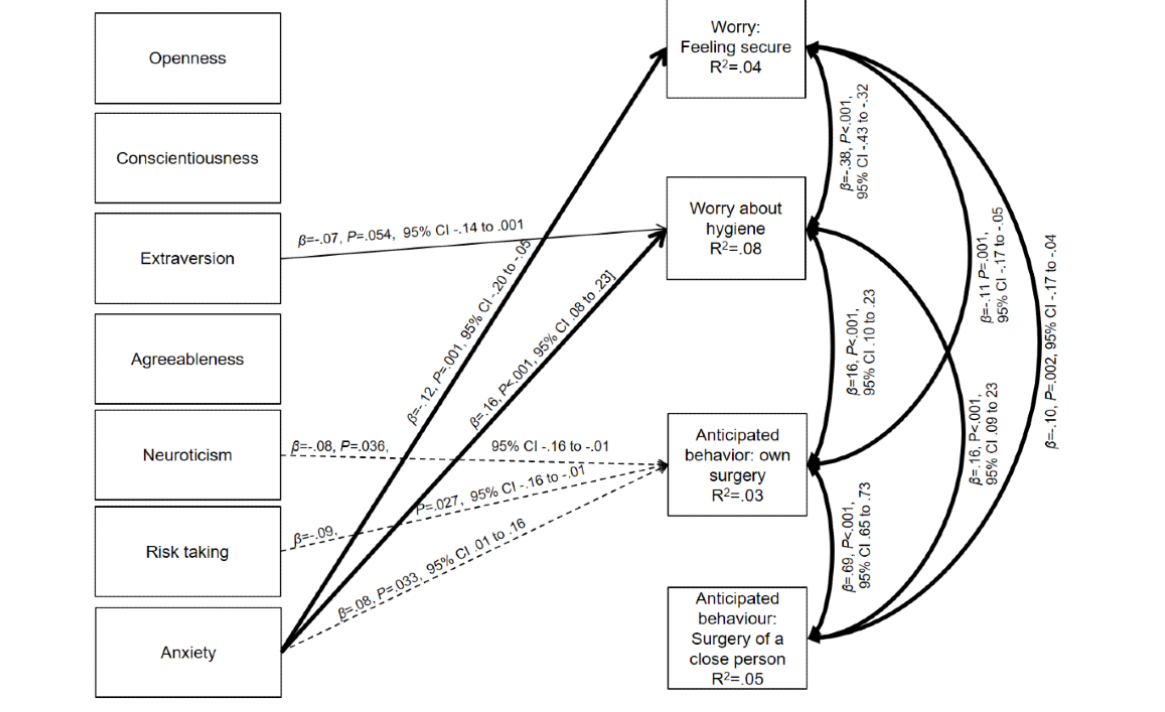
Figure 1. The hypothesized path model for identifying associations between independent variables (ie, personality traits, risk-taking behaviors, and anxiety) and dependent variables (ie, worries about safety, worries about hygiene, and anticipated behaviors). The model used data from 929 participants. We did not display the control variables (ie, risk profiles, information-seeking behaviors, age, gender, and education) to keep the model overview simple. Dotted lines refer to P values of ≥ .01 and ≤ .05. Bold lines refer to P values of <.001. Thin lines refer to P values of ≥ .05. We did not display correlations between the control variables and outcomes to keep the model overview